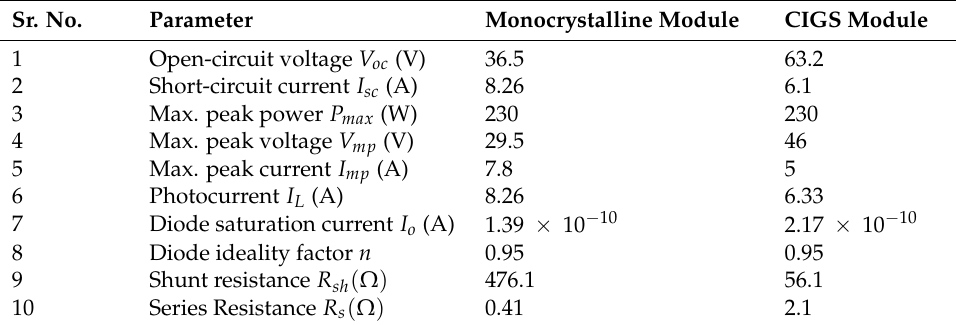
Table 3. Parameters of the studied solar modules. Sr.